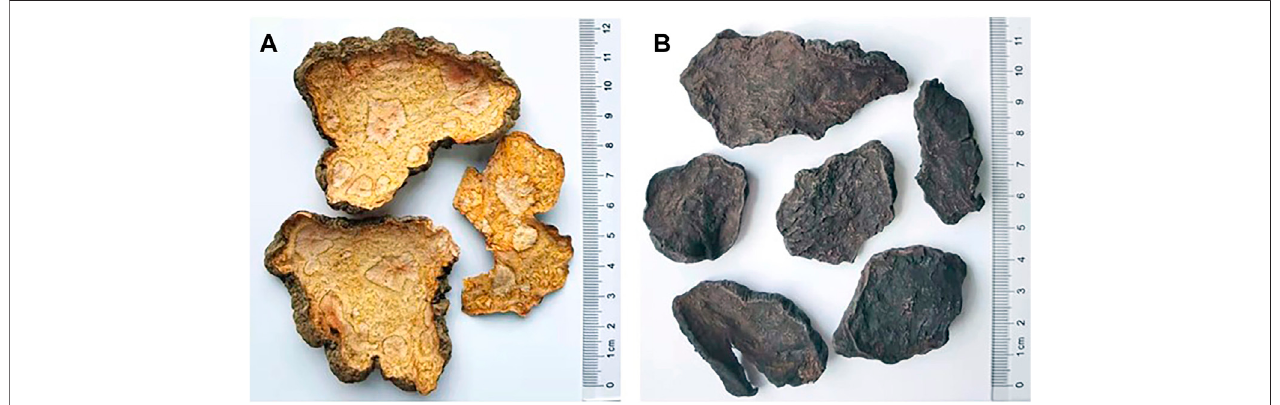
FIGURE 1 | The roots of Polygonum multi fl orum Thunb (A) raw product, and (B) processed product.